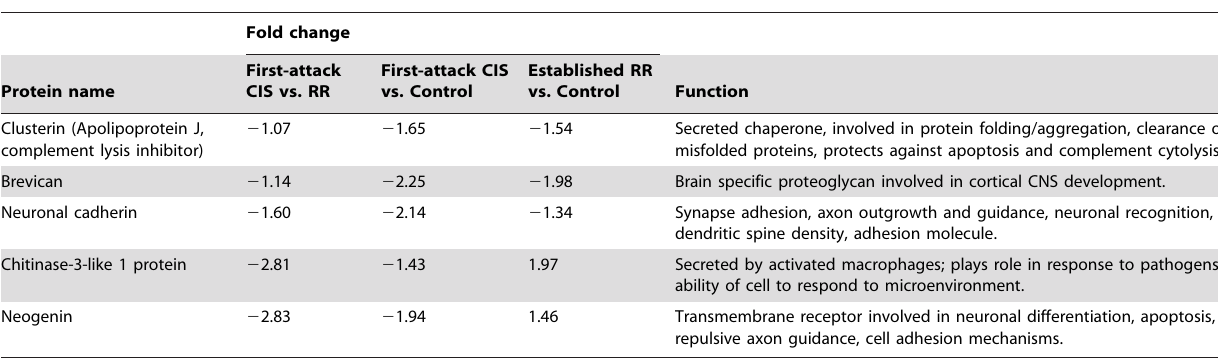
Table 2. Decreased in first-attack CIS-MS vs established RR-MS and controls.